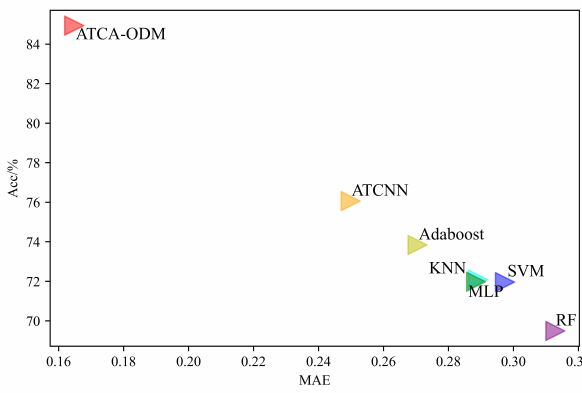
Figure 9. Acc and MAE of 7 different